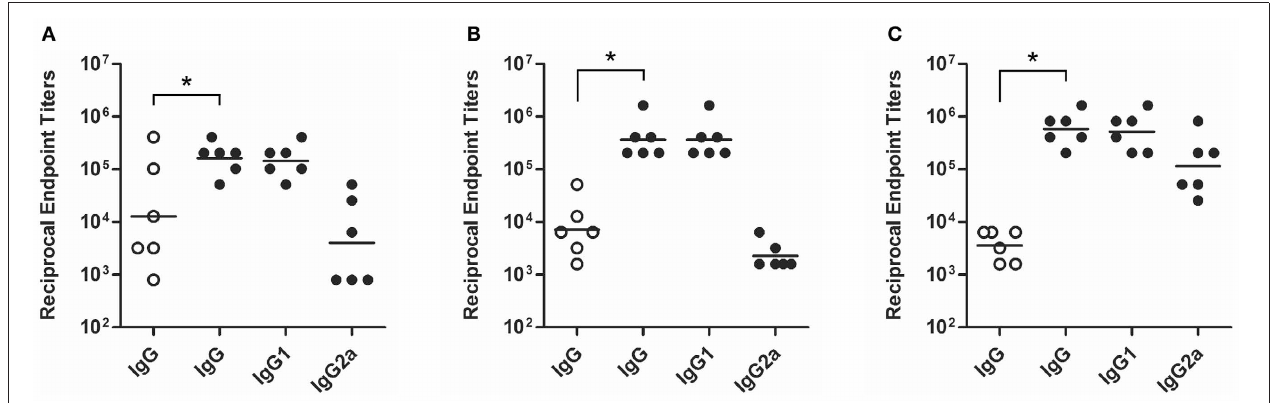
FIGURE 4 | Characterization of serum immunoglobulin responses following immunization of mice with the OPS1B1 glycoconjugate. ELISA was used to determine the serum IgG responses of mice immunized with OPS1B1 (filled circles) or the unconjugated controls (OPS + cBSA; open